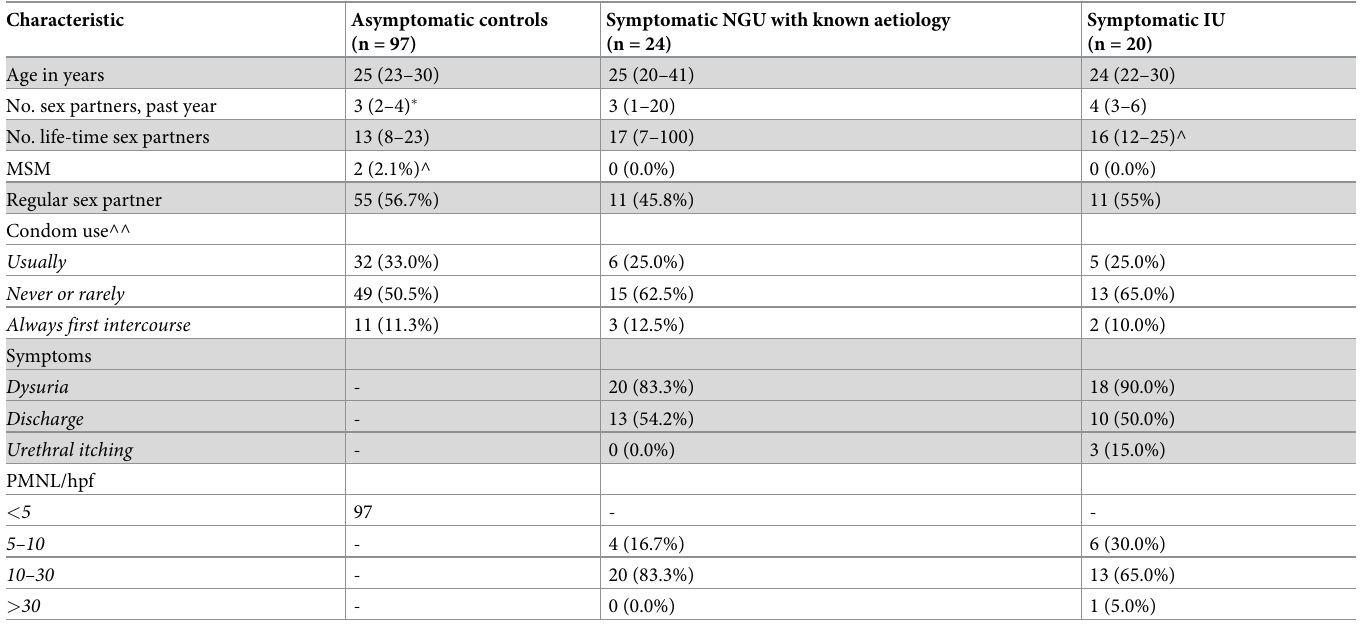
Table 1. Characteristics of patients (n = 141) in the groups “Asymptomatic controls”, “Symptomatic NGU with known aetiology” and “Symptomatic